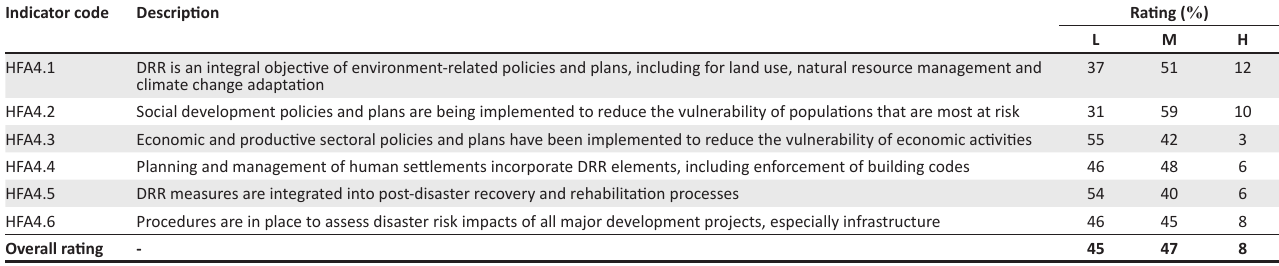
TABLE 5: Perceptions of respondents with regard to achieving Hyogo Framework for Action 4: Reduce the underlying risk factors. Indicator